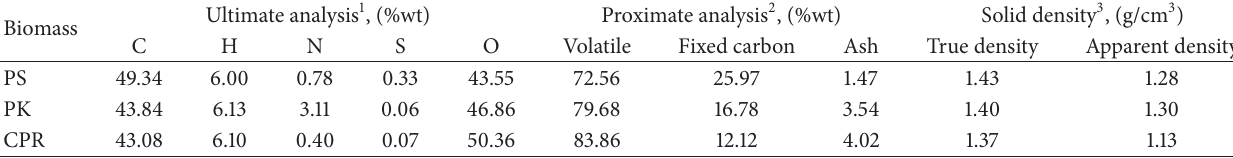
Dry basis. 3 Particle size of 1.55mm.